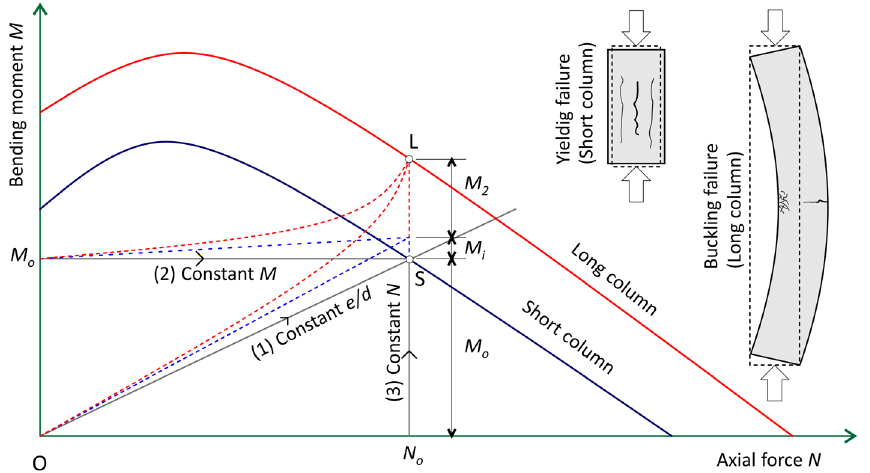
Figure 1. Interaction curves and load paths.